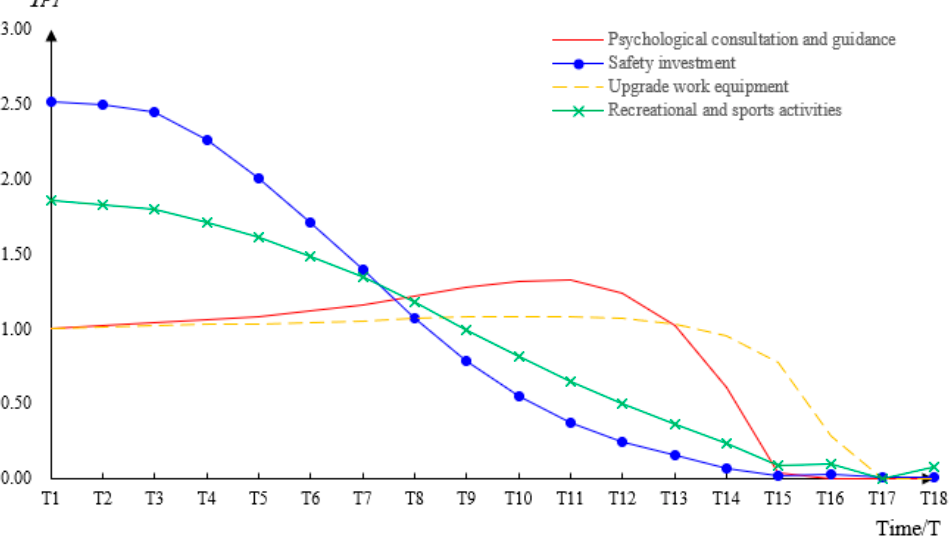
Figure 5. The analysis of I PT change with T based on EAP system.